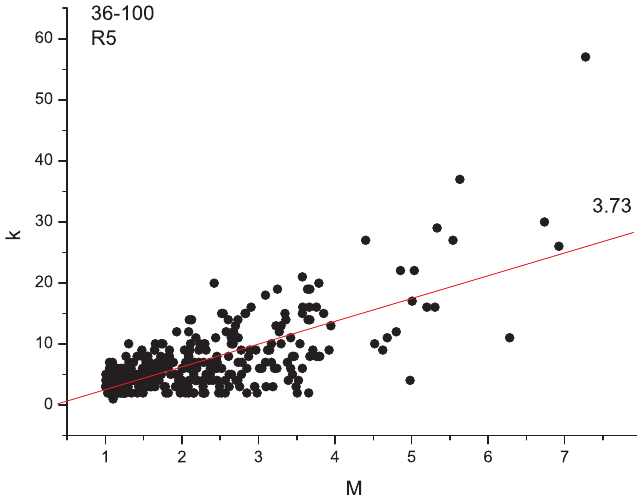
Figure 6. k-M plot and LSM fitting line during run R5.